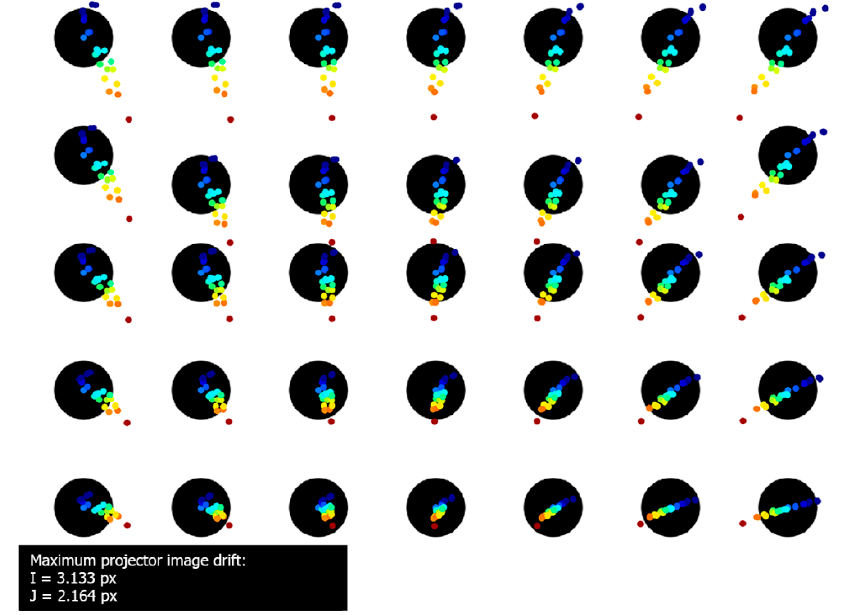
Figure 12. Thermal image drift of the DLP LightCrafter4500 projector, presented in the coordinates of the projector. The marker colors show the temperature of the projector and correspond to the colors in Figure 10.